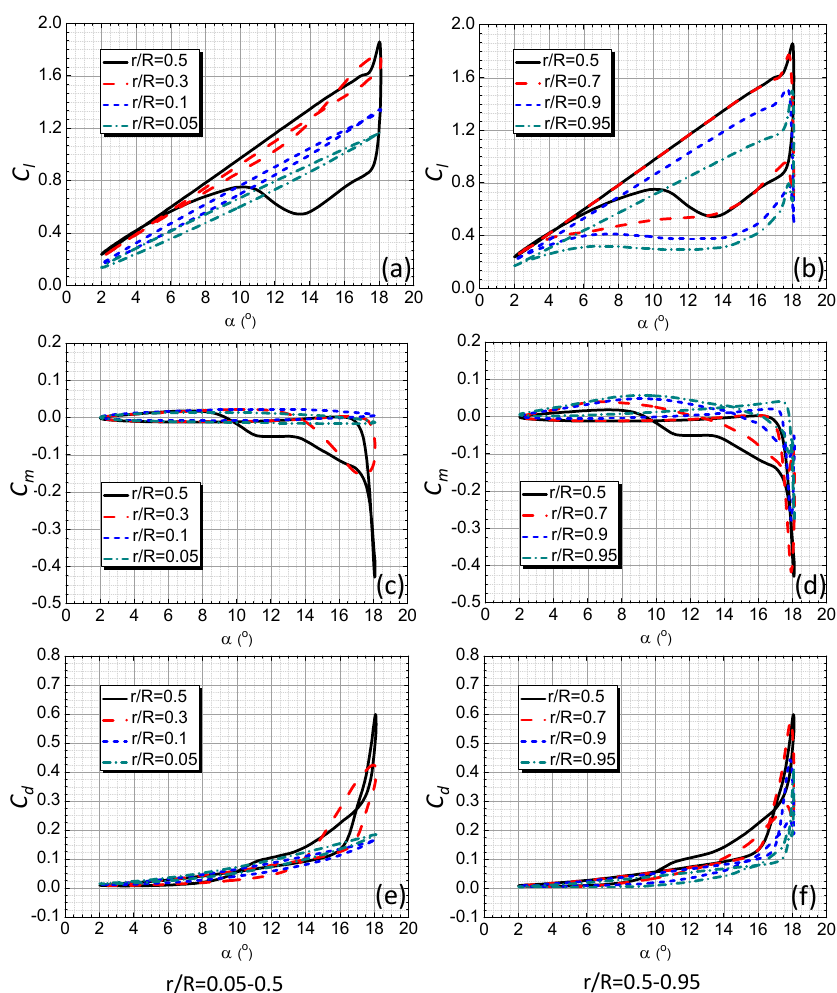
Figure 13. Comparison of aerodynamic-load characteristics at different wing sections. ( a ) C l of wing-root, ( b ) C l of wing-tip, ( c ) C m of wing-root, ( d ) C m of wing-tip ( e ) C d of wing-root, ( f ) C d of wing-tip.